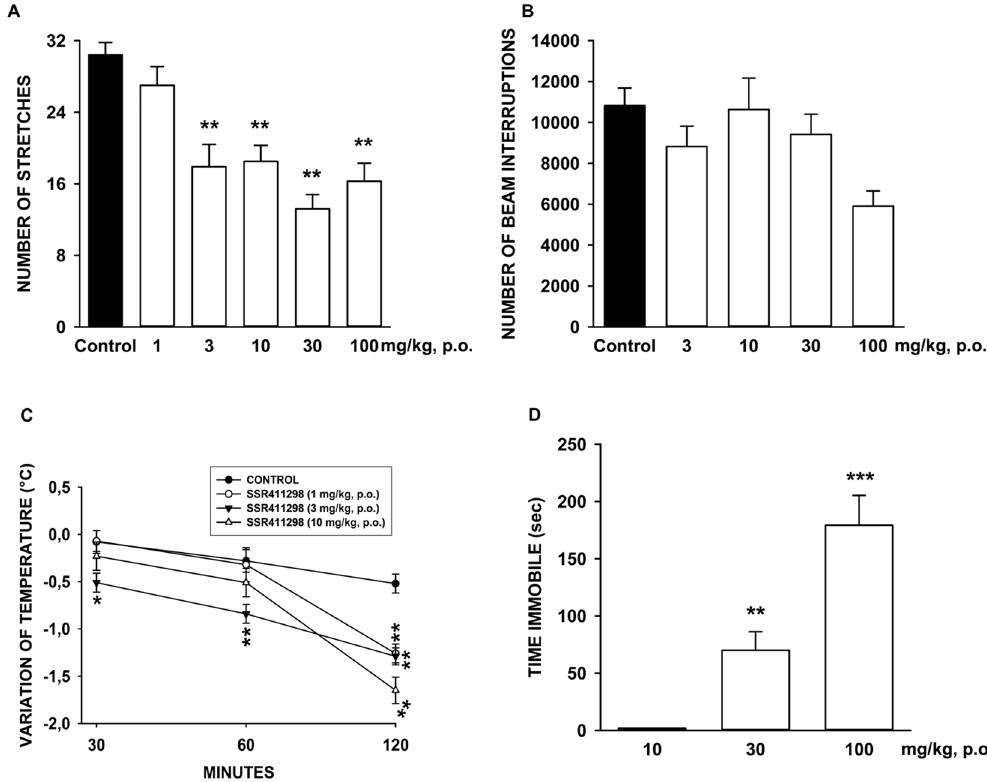
Figure 6. Study of the potential cannabimimetic activity of SSR411298. ( A ) PBQ: number of stretches; ( B ), Ambulation: number of beam interruptions on the horizontal sensors; ( C ) Temperature: °C; ( D ) Ring immobility: time immobile in seconds. ** P < 0.01, *** P < 0.001. Data represent the mean ± SEM. N = 8 to 20.